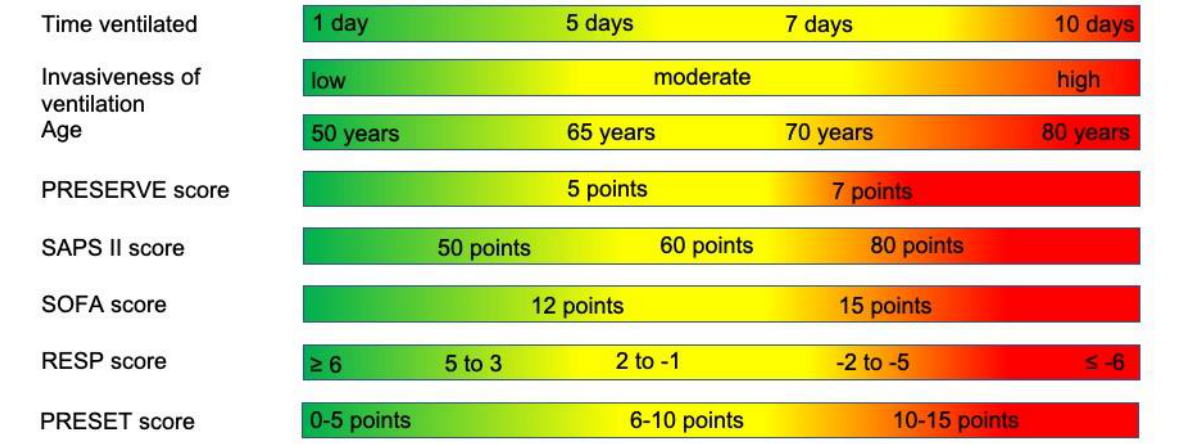
Figure 2. Sliding scales of relative contraindications. This figure is intended to illustrate the interplay between the continuous relative contraindications. A value in a red section in one or two categories can be countered by values in the green or at times yellow sections in another category.